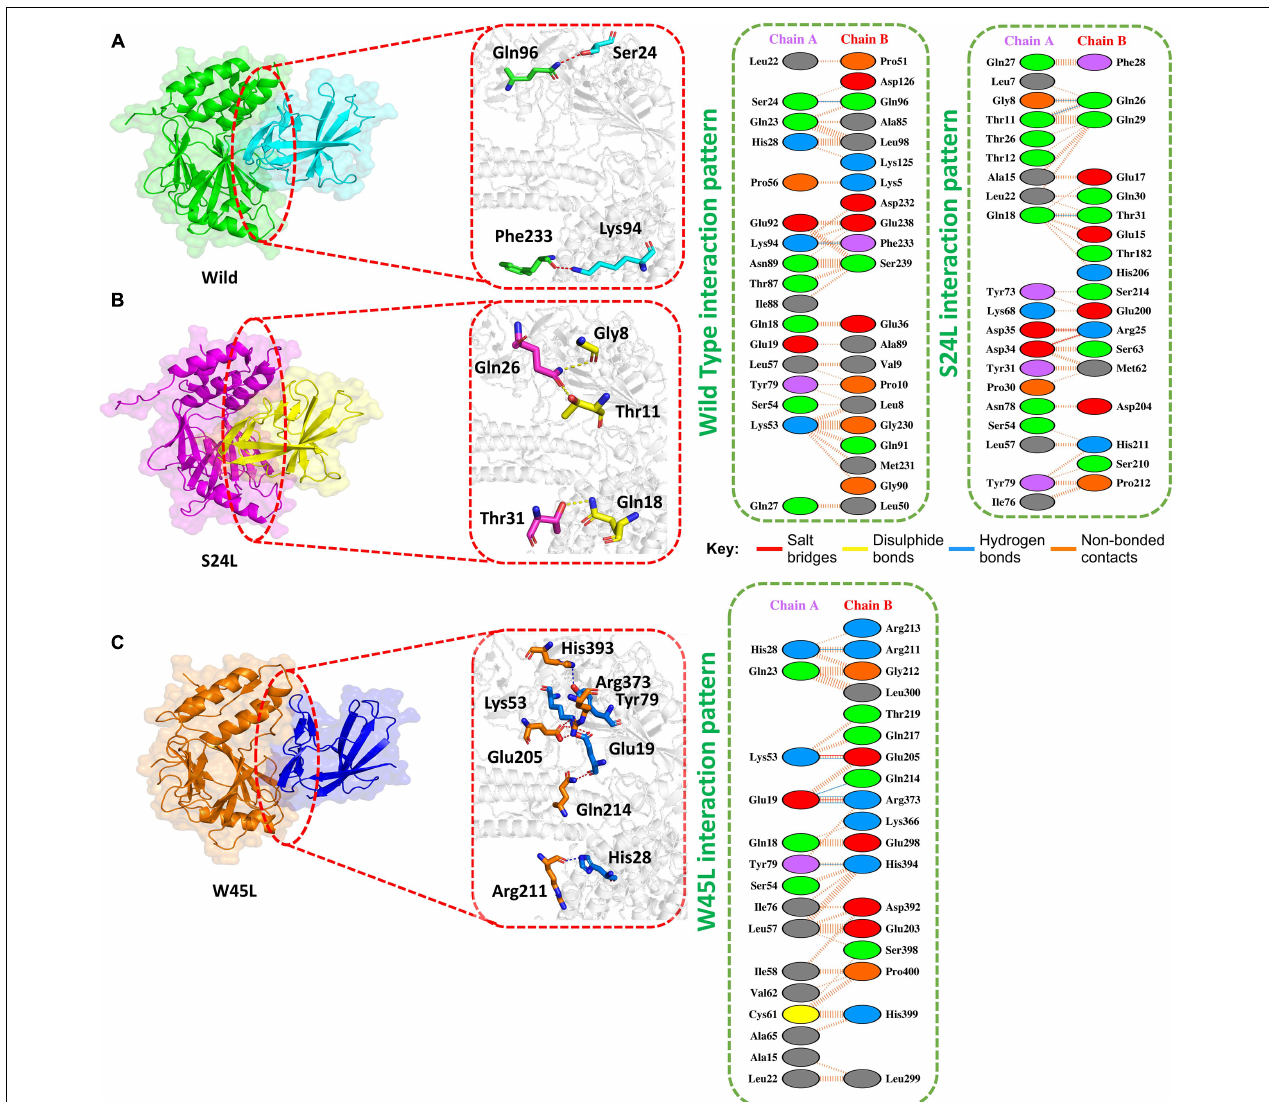
FIGURE 2 | Docking of ORF8 WT, S24L, and W45L mutant complexes. (A) Key hydrogen bonding interactions of the ORF8 WT complex with the IRF3 binding interface along with stick representation of the ORF8 WT complex with IRF3 (left). 2D interaction representing salt bridges, hydrogen, and non-bonded interactions (right). (B) Key hydrogen bonding interactions of S24L mutant with the IRF3 binding interface along with stick representation (left). 2D interactions representing salt bridges, hydrogen, and non-bonded interactions (right). (C) Key hydrogen bonding interactions of the W45L complex with the IRF3 binding interface along with stick representation of the ORF8 WT complex with IRF3 (left). 2D interaction representing salt bridges, hydrogen, and non-bonded interactions